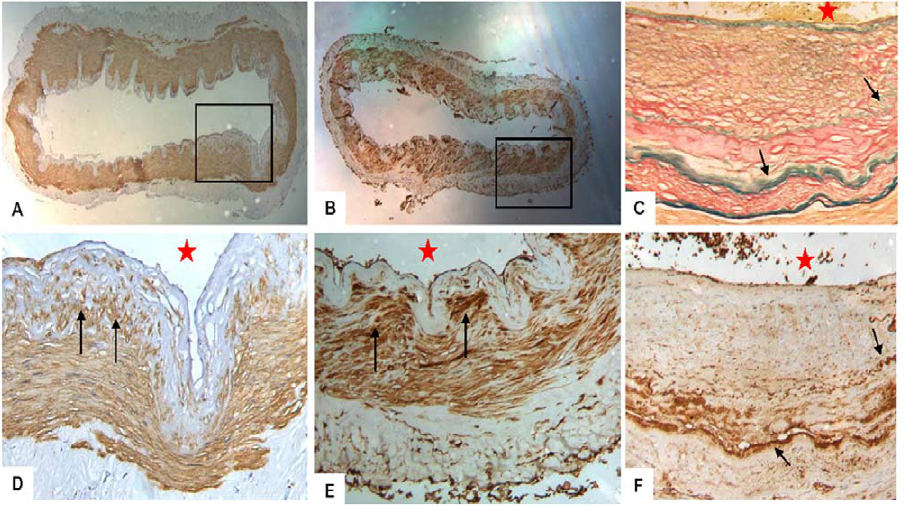
Figure 5. Immunohistochemical study of intracranial arteries. A and D: immunoreactivity indicating that a -SMA is detected in the thickened intima of MCA of patients with MMD (black arrows), Figure 5D is an enlarged region (box) of Figure 5A; B and E: immunoreactivity indicating that S100A4 protein is detected in the thickened intima and media smooth muscle cells (black arrows), Figure 5E is an enlarged region (box) of Figure 5B; F: vascular smooth muscle cells, especially the damaged internal elastic lamina, showed intense immunoreactivity of IgG (black arrows); C: the same area of Figure 5F, black arrows indicate the stratified internal elastic lamina (Ponceau/Victoria blue staining). The red stars indicate lumen of the blood vessels. (A, B) 6 40, (C, D, E, F) 6 200.